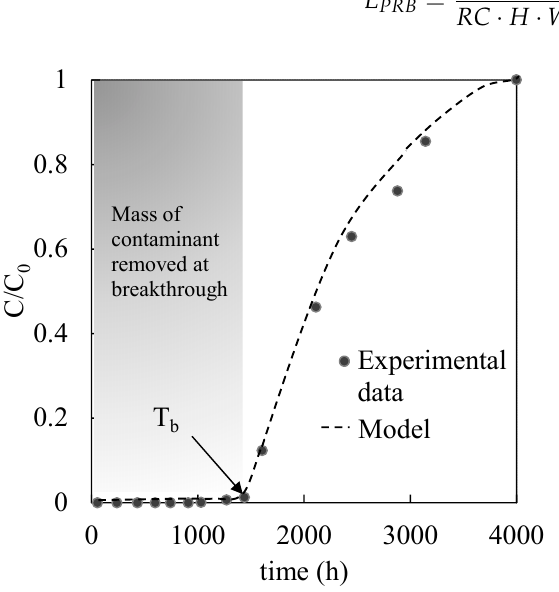
Figure 5. The expected breakthrough curve for a fixed sampling port.